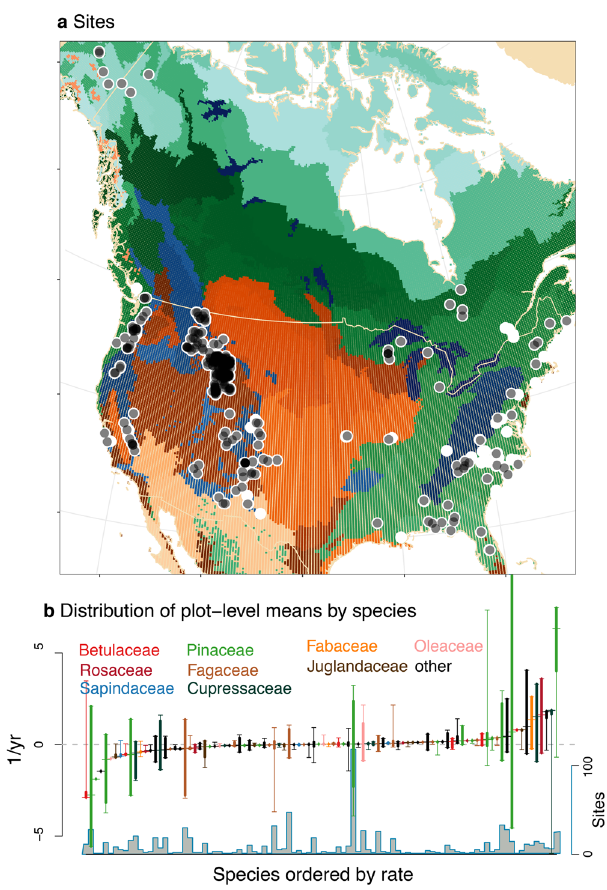
Fig. 3 Sites and species trends. a Longitudinal studies in black (opacity proportional to numbers of sites) and opportunistic in white. Shaded ecoregions are desert/shrub/grass (browns), montane (blues), and mixed forest (greens). b Trends in mean log (proportionate) fecundity by species from sites in a range from negative (declining) to positive. As would be the case for any meta-analysis, the time scales for which trends are evaluated vary (see “ Methods ” section). Species belong to color-coded families below that are listed in Supplementary Data 2. There is no relationship with phylogeny (i.e., no trend in box color from left to right). Summaries in b include mean (crosshairs), 95% of site means (bold line), and range of site means (whiskers). The number of sites ( n ) contributing to b is shown